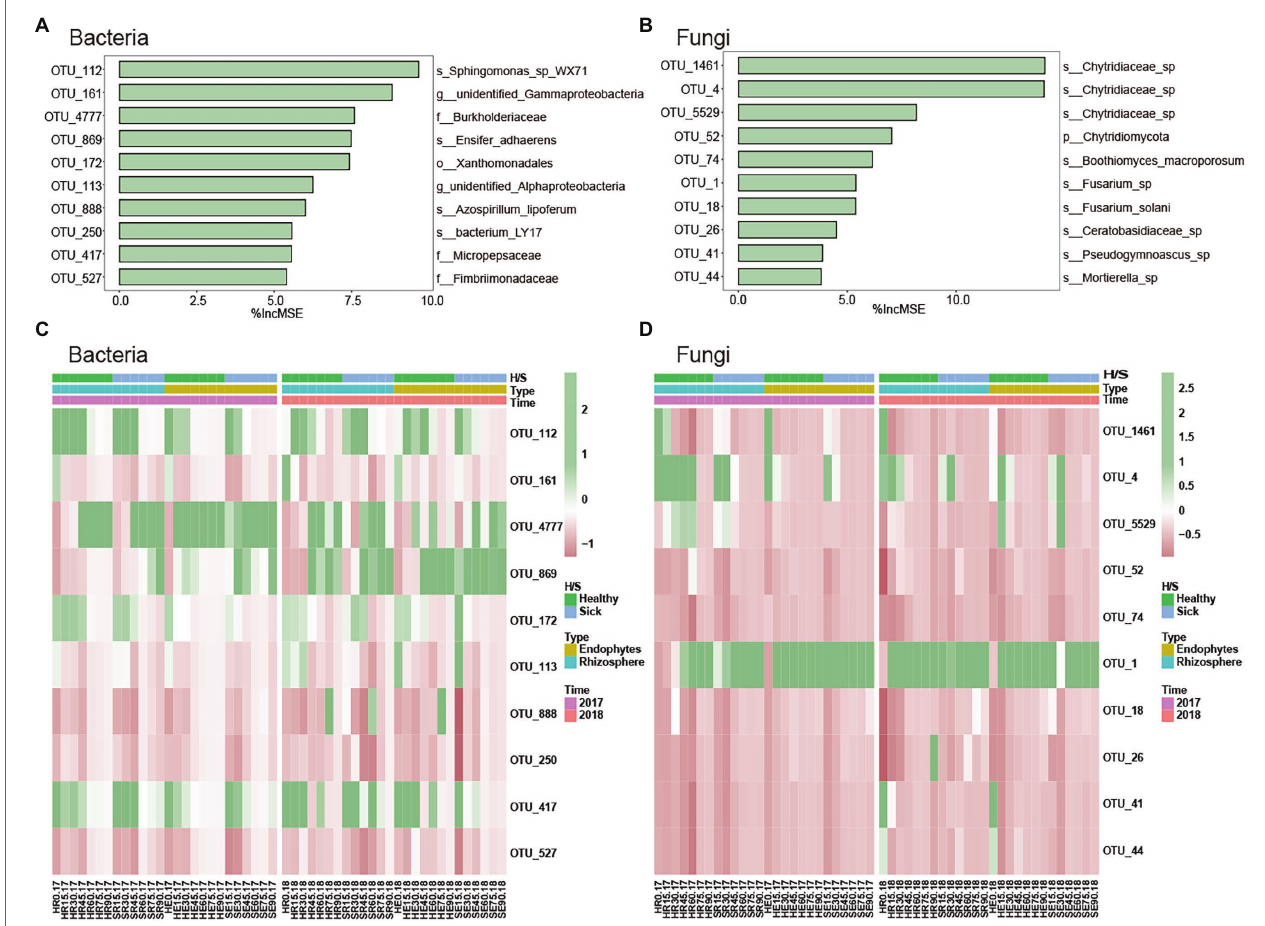
FIGURE 4 | Major differential microbial species in RKN-infected and healthy tobacco root microorganisms in different growth stages. (A,B) The top 10 OTUs selected according to %IncMSE through random forest. (C,D) Heatmap of the relative abundances of important biomarker